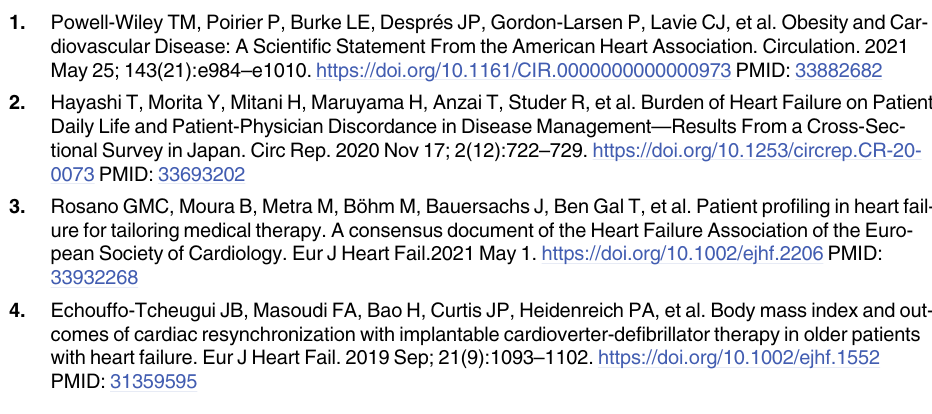
S3 Fig. (A). eGFR, GNRI, and serum cholinesterase cut-off values determined by ROC analy- sis for the prediction of cardiac events by combination with the cut-off values of three parame- ters in the group of patients with LVEF < 40%. (B). eGFR, GNRI, and serum cholinesterase cut-off values determined by ROC analysis for the prediction of cardiac events by combination with the cut-off values three parameters in the group of patients with LVEF ≧ 40%. (TIFF) S4 Fig. (A). eGFR, GNRI, and serum cholinesterase cut-off values determined by ROC analy- sis for the prediction of cardiac events by combination with the cut-off values of three parame- ters in the ischemic etiology group. (B). eGFR, GNRI, and serum cholinesterase cut-off values determined by ROC analysis for the prediction of cardiac events by combination with the cut- off values of three parameters in the non-ischemic etiology group. (TIFF) S5 Fig. (A). eGFR, GNRI, and serum cholinesterase cut-off values determined by ROC analy- sis for the prediction of cardiac events by combination with the cut-off values of three parame- ters in the group of patients with BMI ≦ 20 (25% quantile). (B). eGFR, GNRI, and serum cholinesterase cut-off values determined by ROC analysis for the prediction of cardiac events by combination with the cut-off values of three parameters in the group with 20 < BMI < 25. (C). eGFR, GNRI, and serum cholinesterase cut-off values determined by ROC analysis for the prediction of cardiac events by combination with the cut-off values of three parameters in the group of patients with BMI ≧ 25 (75% quantile).